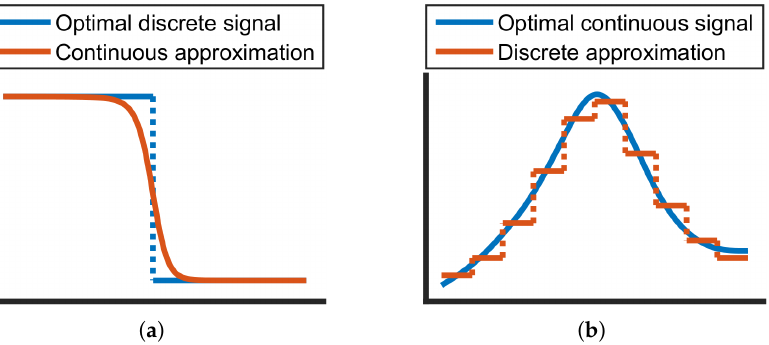
Figure 4. Illustrated example of the error created when attempting to approximate an optimal signal with differing continuity signals. Attempting to use a continuous approximation of a discrete signal, ( a ) results in rounding errors near the discrete step. Attempting to use a discrete approximation of a continuous signal, ( b ) results in errors as the target signal cannot be followed